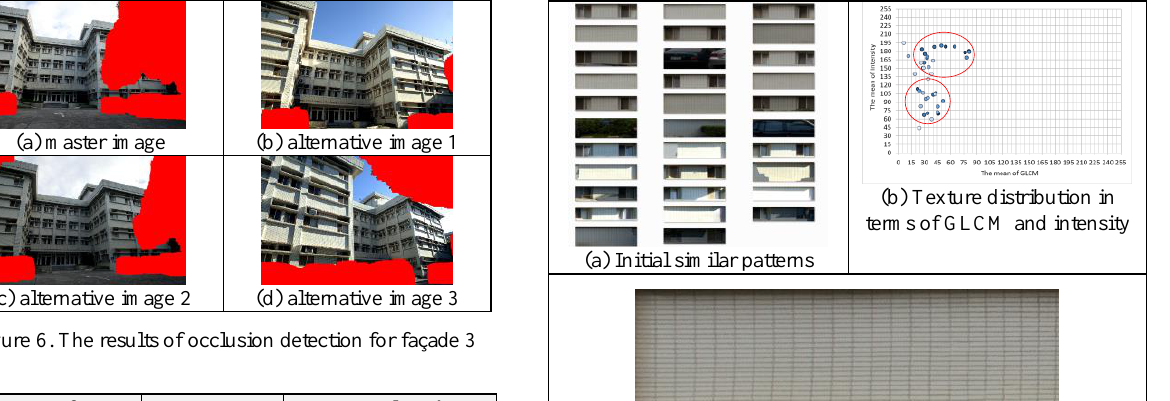
No. Selected No. Patches Textures